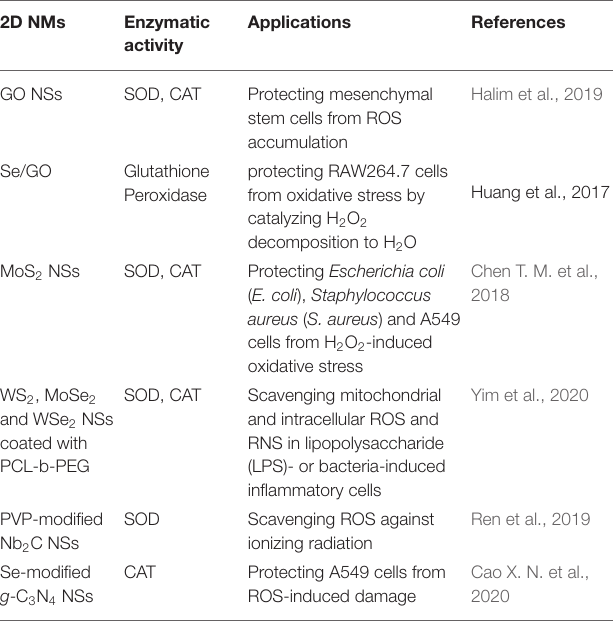
TABLE 3 | Summary of representative 2D nanozymes as